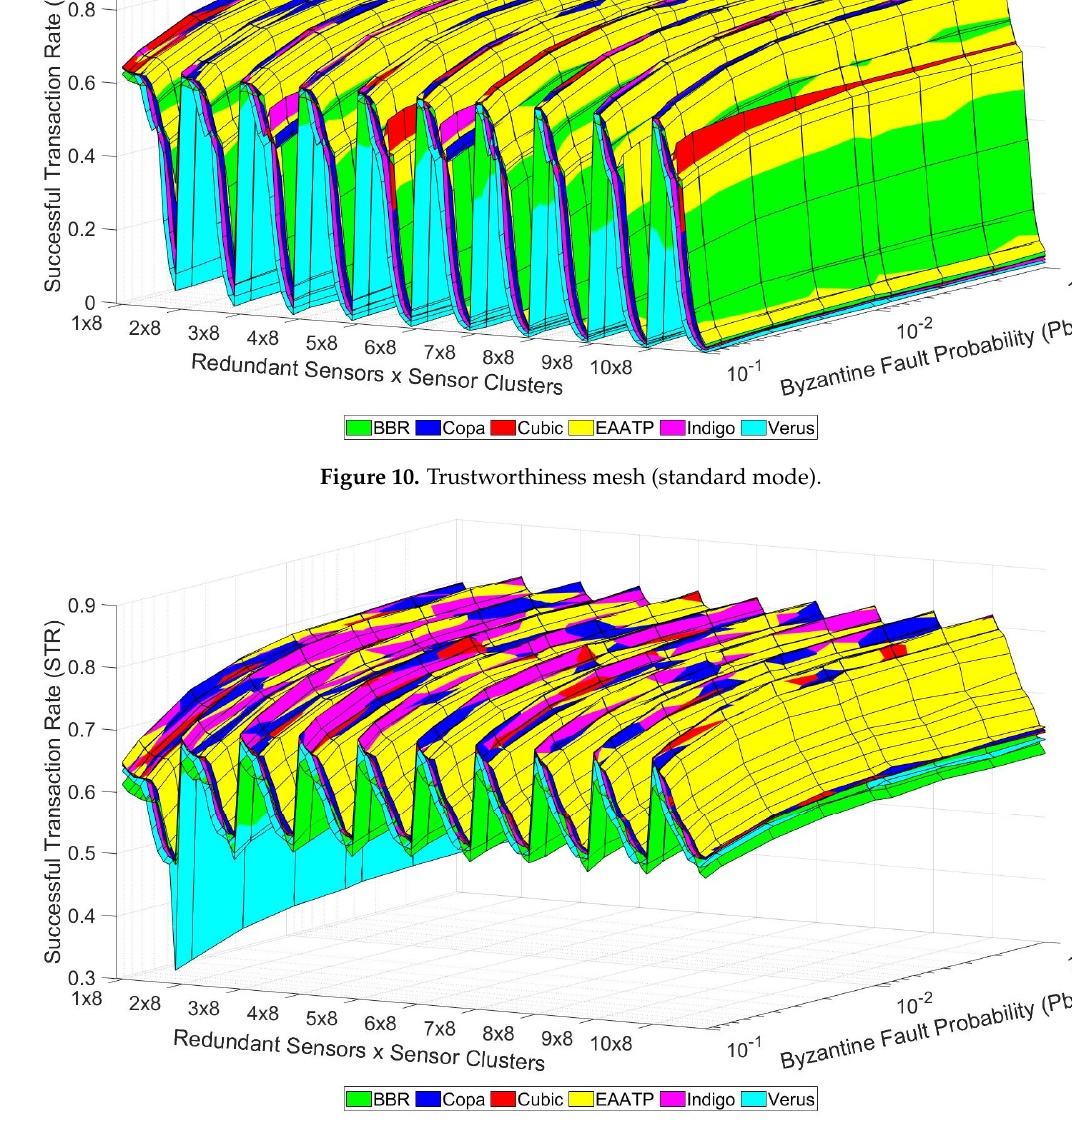
Figure 11. Trustworthiness mesh (social trustworthiness).